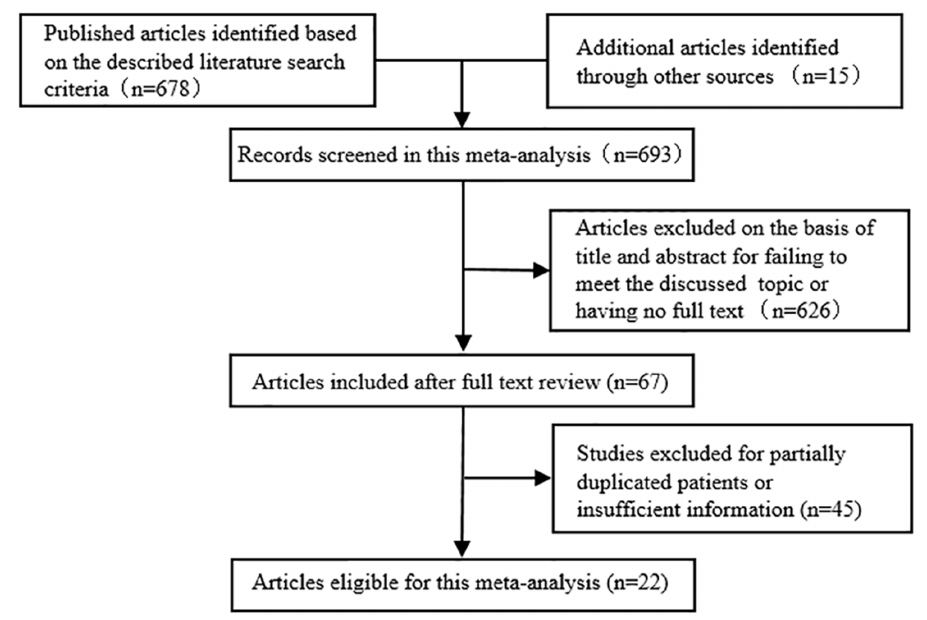
Figure 1. Flow chart of literature search strategies.